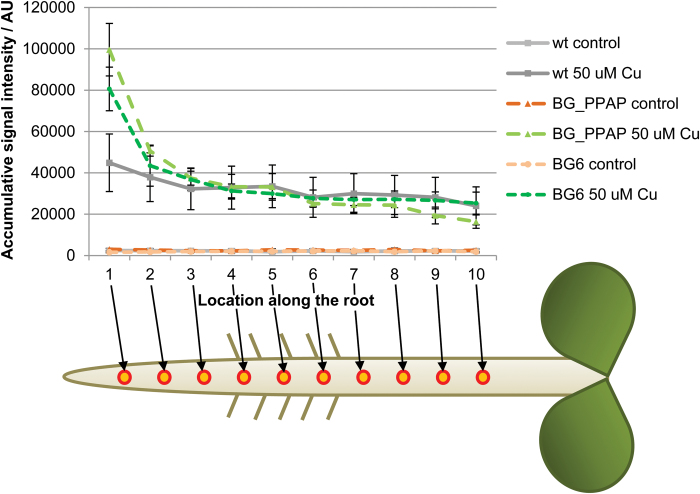
β-1,3-Glucanase mutants accumulate excess copper in the root tip. Accumulative signal intensity of copper in arbitrary units (AU) in the wild type, bg_ppap, and bg6 after 24 h of 50 µM Cu; n=3 for each group. The x-axis corresponds to the location of the sample taken along the root, with punch 1 being at the meristem and moving shootwards.